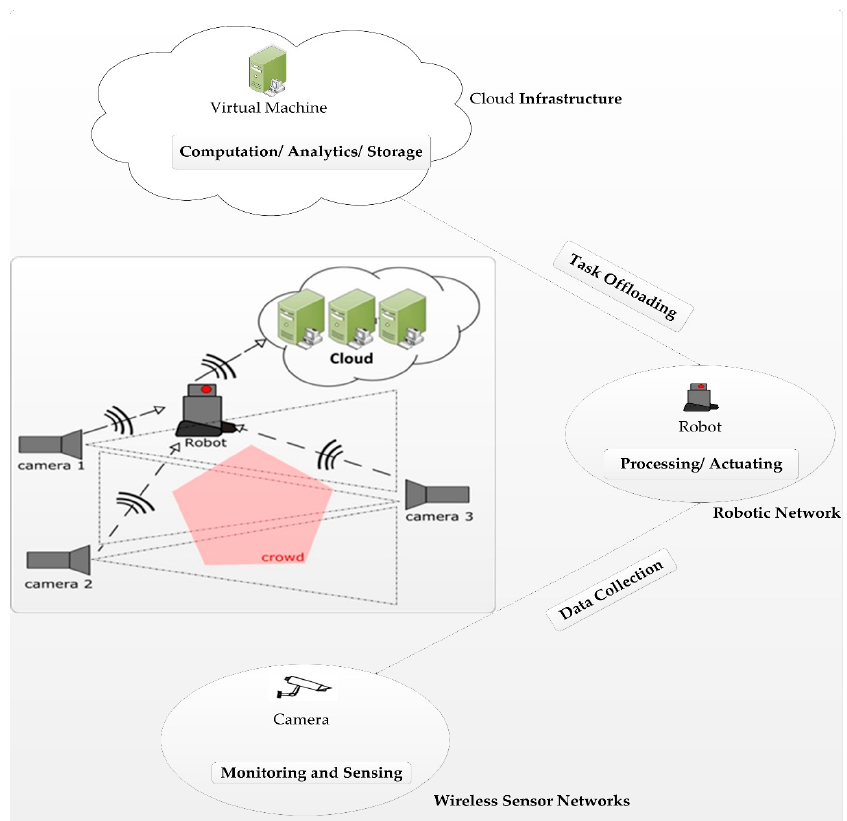
Figure 1. A smart city cloud robotics framework.